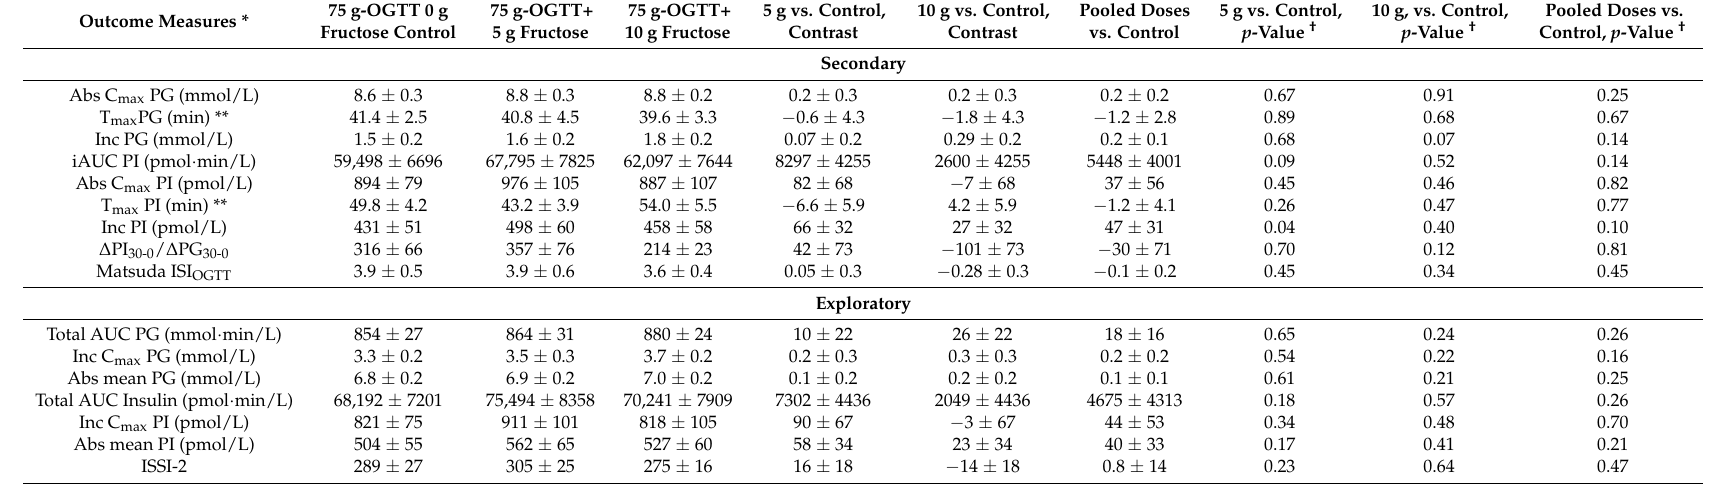
Table 2. Secondary and exploratory outcomes for the effects of fructose on postprandial carbohydrate